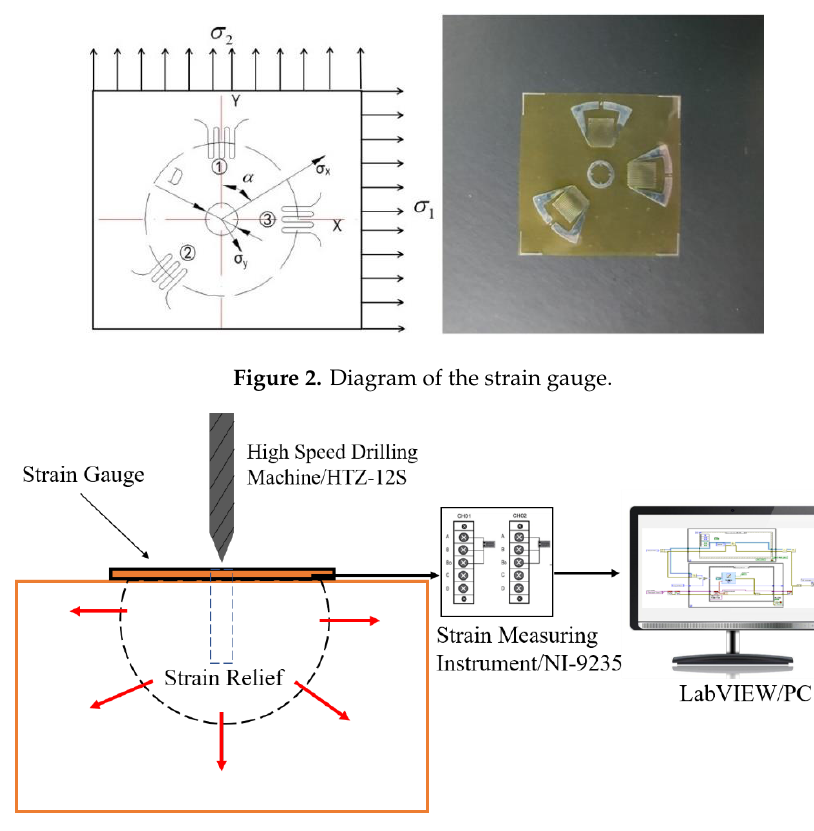
Figure 3. Experimental schematic diagram for measuring welding residual stress (WRS) of blind hole method.